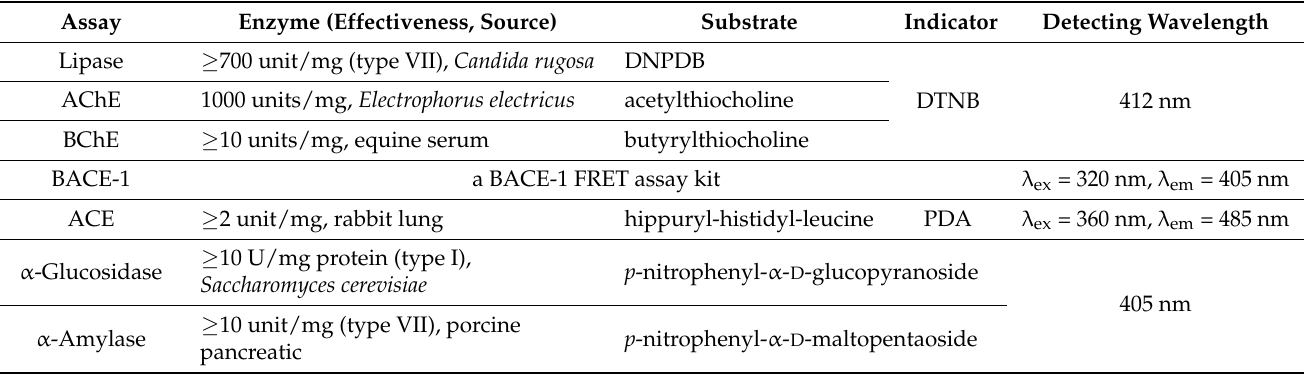
Table 1. The components of the inhibitory